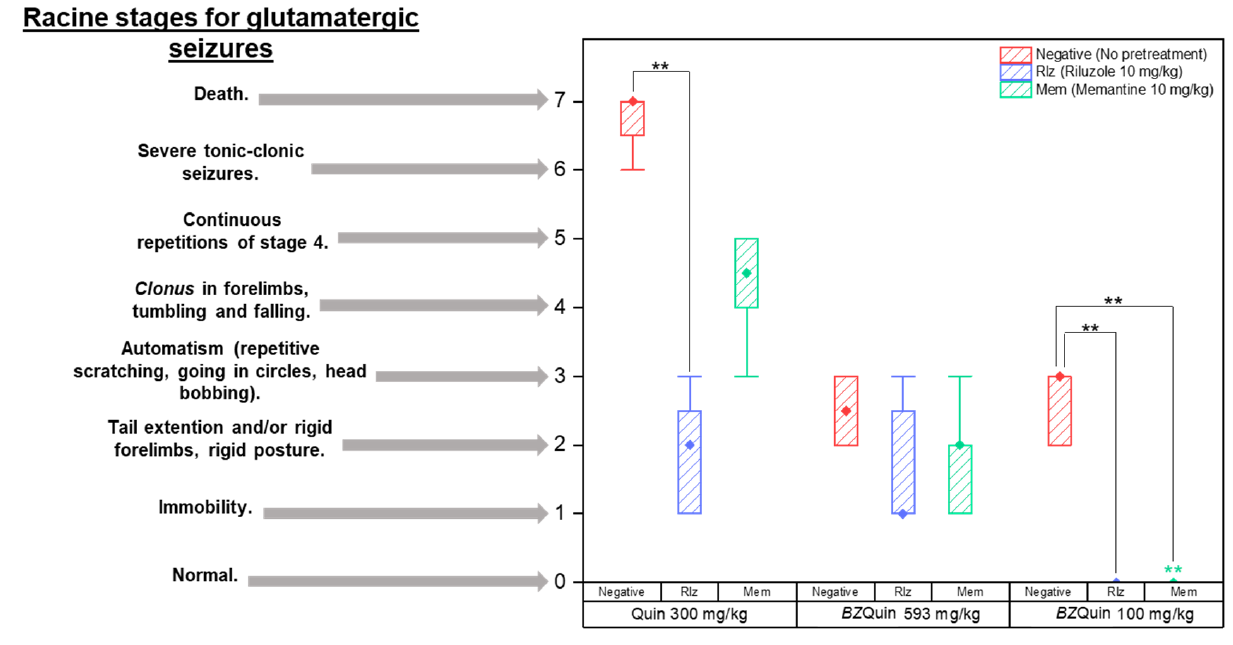
Figure 9. Classification of the intensity of seizures (Racine stages). Non ‐ normal distribution data not considering the vehicle group. Racine stage (pretreatment): negative > Rlz = Mem, p < 0.001. Racine stage (Stimulating agent): Quin 300 mg/kg > BZQuin 593 mg/kg > BZQuin 100 mg/kg, p < 0.001. ** p < 0.001. ** p < 0.001 compared with the Mem group with Quin at 300 mg/kg.